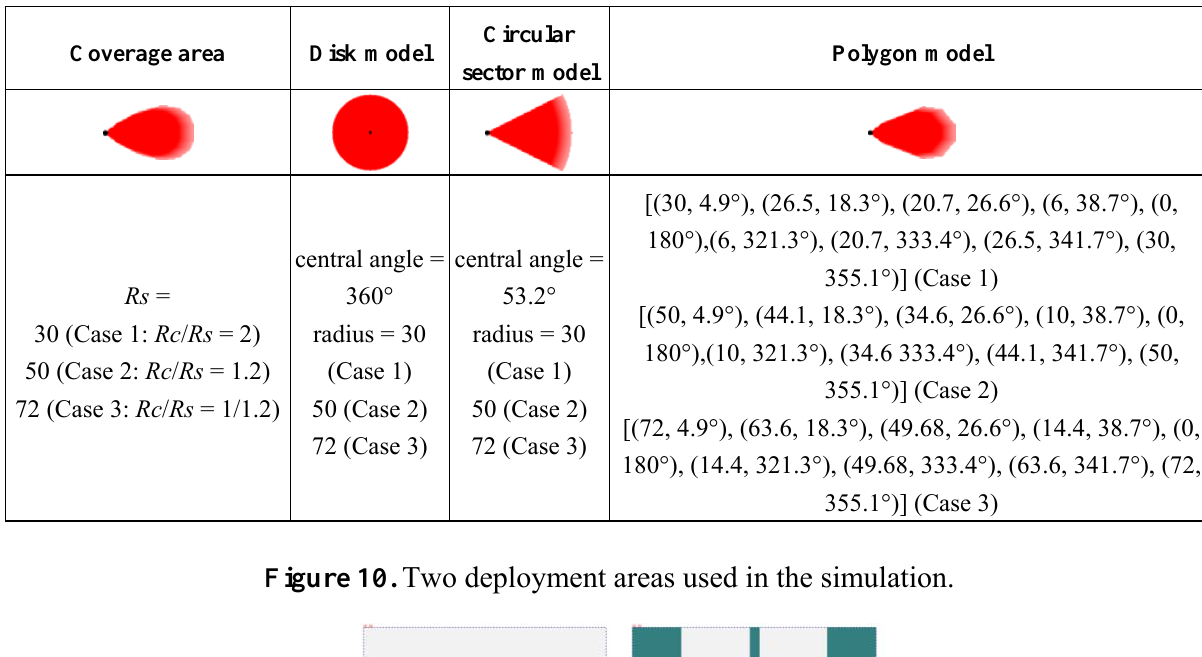
Table 3. The coverage areas of directional sensor under different models.